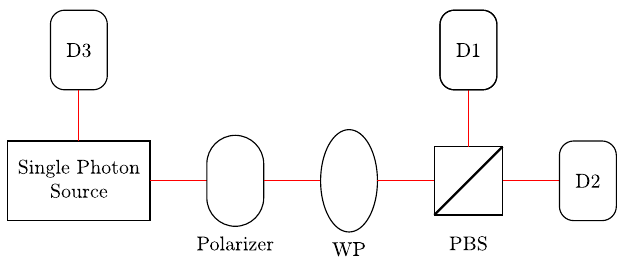
Fig. 8. Schematic diagram of the alternative